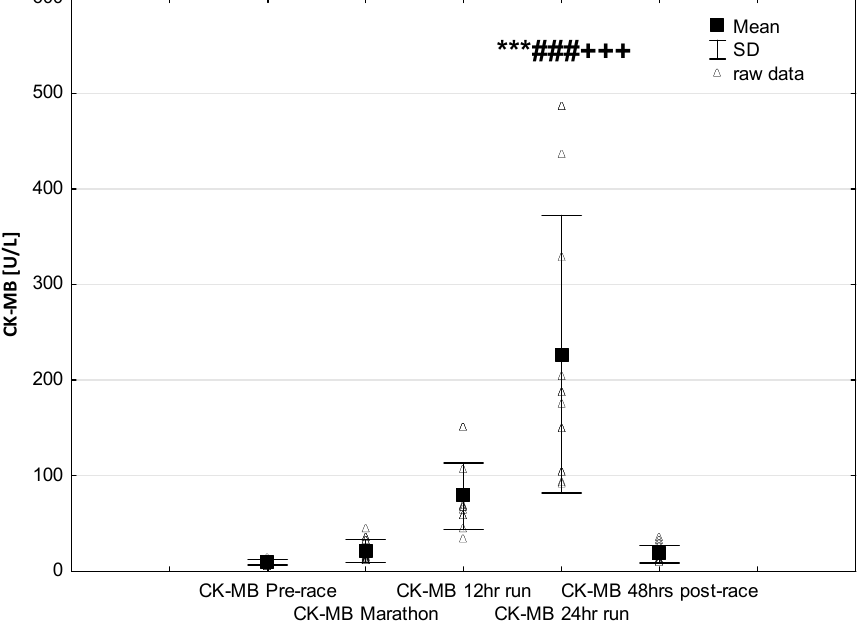
Figure 2. Ultra-marathon-induced changes in serum creatinine kinase-myocardial band (CK-MB). *** p < 0.001 versus the corresponding pre-run value (Pre-race); ### p < 0.001 versus the corresponding post-marathon value (Marathon); +++ p < 0.001 versus the corresponding post 12-h run value (12-h run).